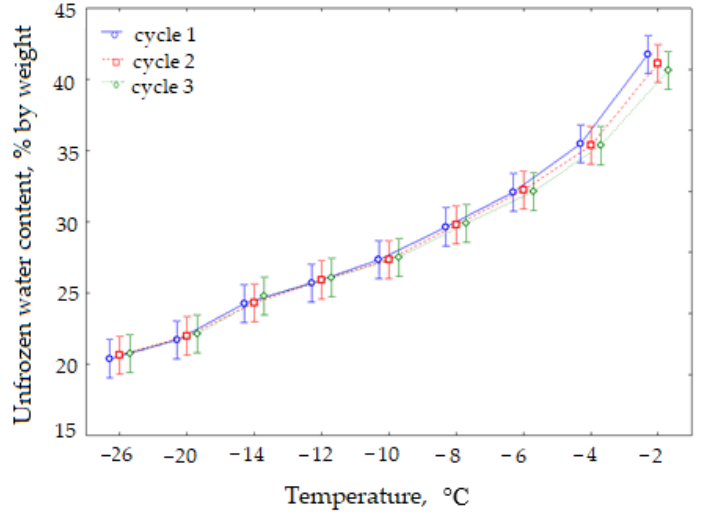
Figure 4. Graph of the mean unfrozen water contents at a given negative temperature, depending on the F-T cycle, regardless of the type of copper bentonite ‘Cu’ (Stx-1b; BSvk).